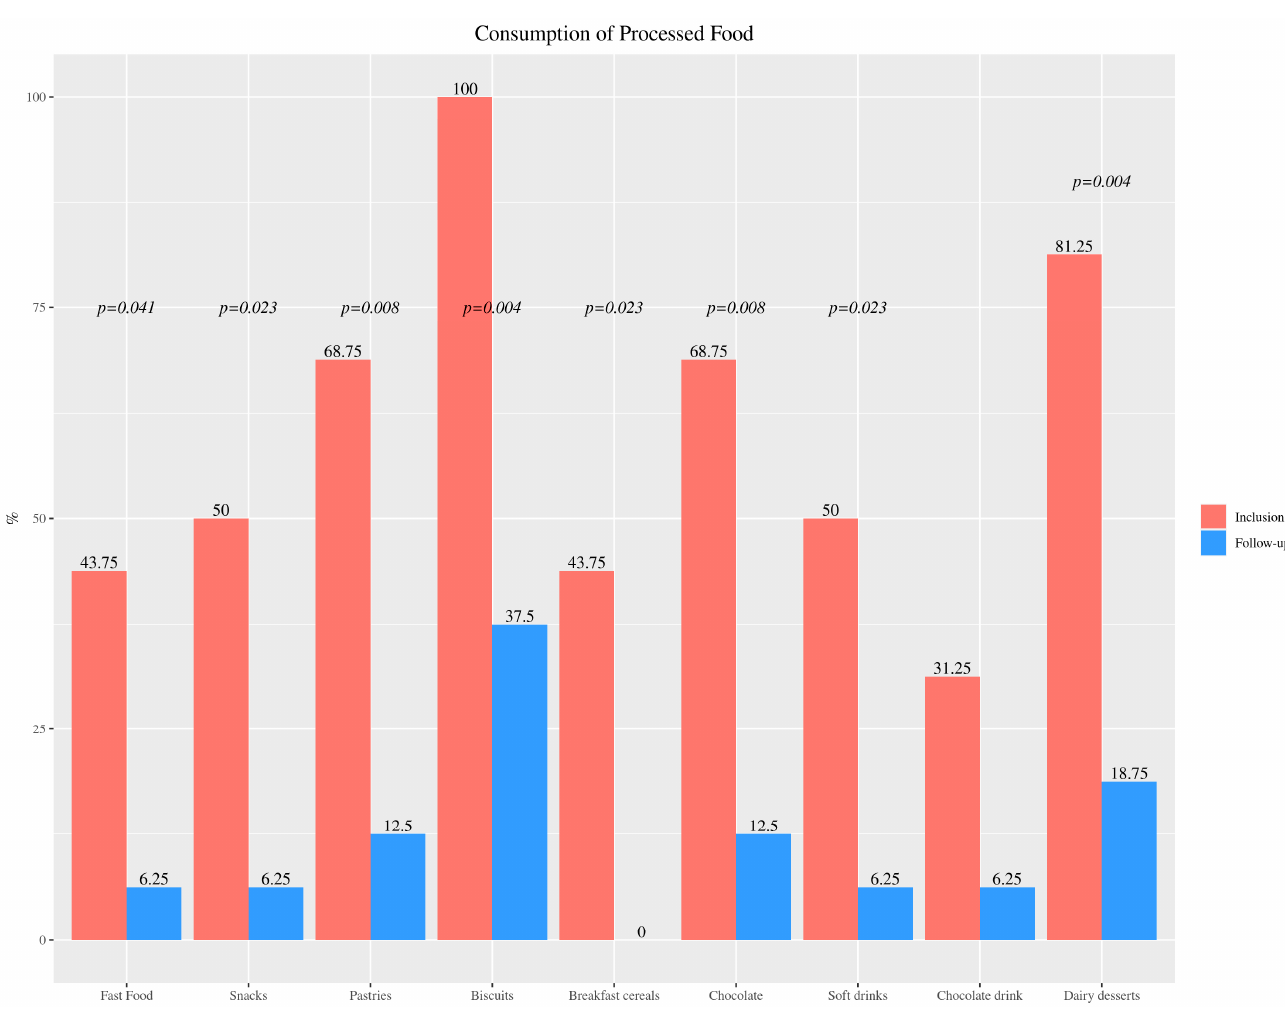
Figure 3. Percentage of the 16 participants with chronic kidney disease that consumed different processed foods (fast food, snacks and soft drinks at least once a week; pastries, biscuits, chocolate and breakfast cereals 2 to 7 times a week; chocolate drinks and dairy desserts daily) at baseline and last follow-up.